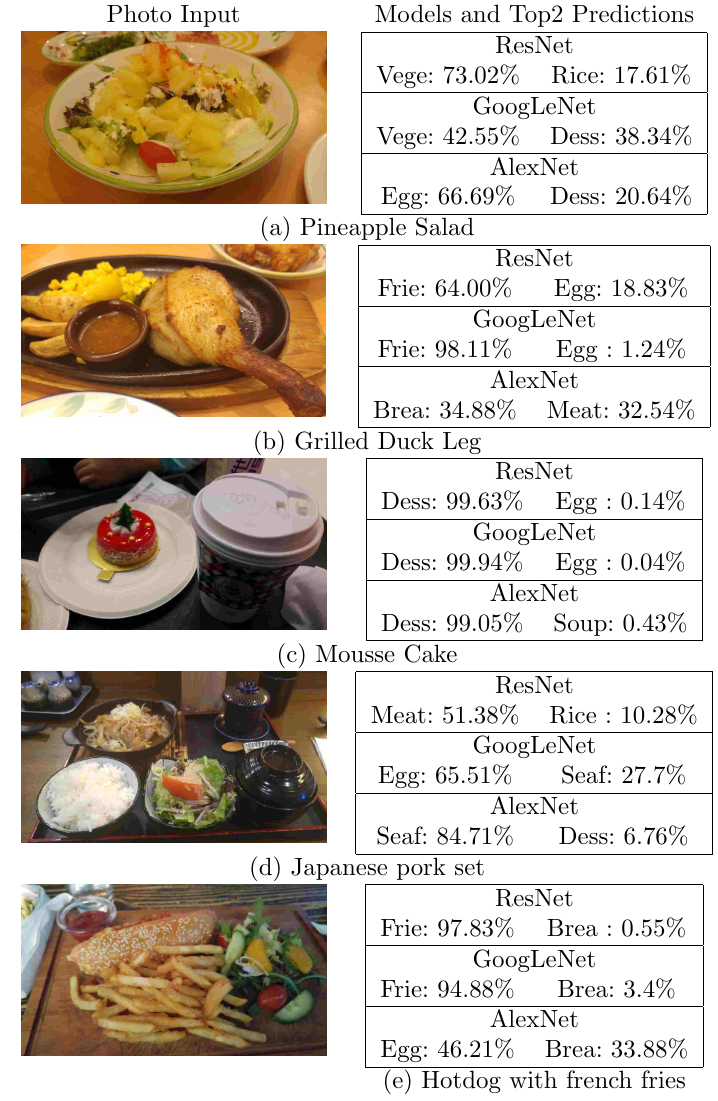
Figure 10. Sample results using our own users’ contributed photos. We indicate some of the classes in short due to space limit. E.g. Brea: Bread, Frie: Fried Food, Seaf: